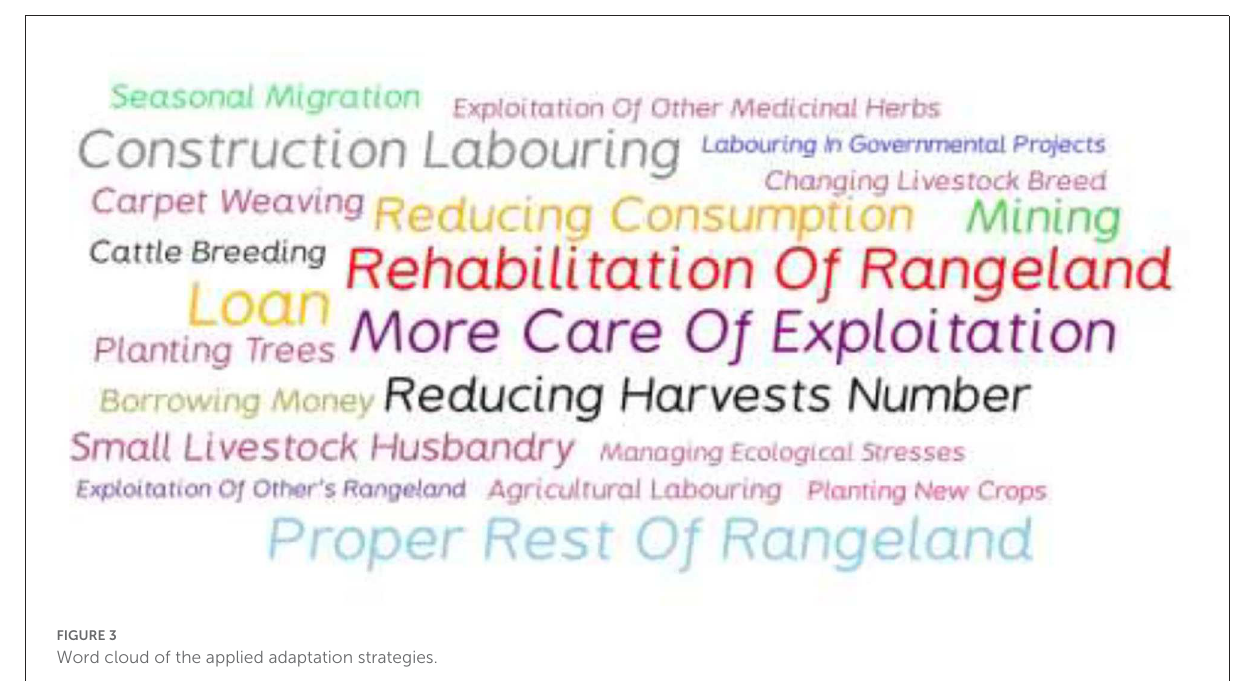
FIGURE3 Word cloud of the applied adaptation